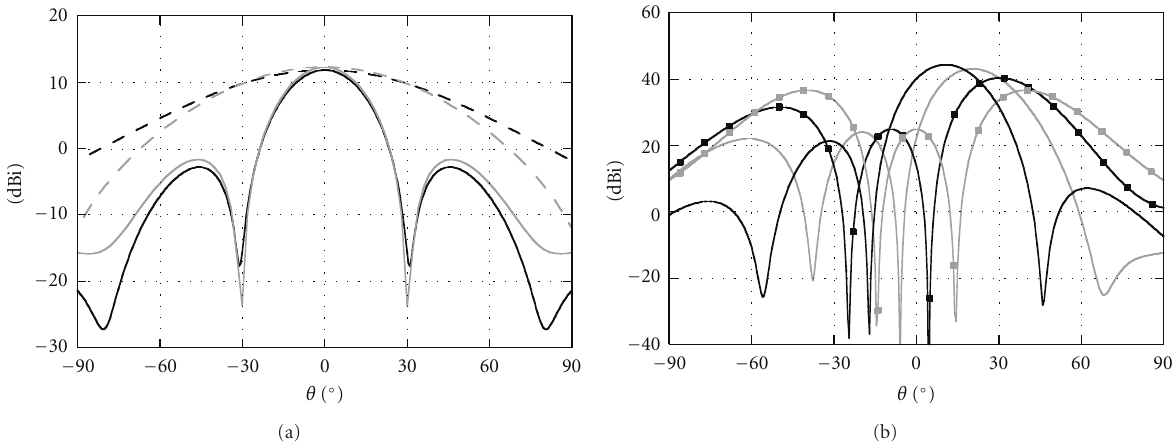
Figure 9: Array of 3 adjacent shielded cells as in Figure 2 at 5GHz. (a) Gain on the principal elevation planes φ = 0 ◦ ( solid lines ) and φ = 90 ◦ ( dashed lines ). Beam pointing at broadside ( θ = 0 ◦ , all the cells are excited in phase) by the upper patches ( black lines ) and by the lower patches ( gray lines ). (b) The three lower sets of patches are phased in order to point at θ = 10 ◦ ( black line ), θ = 20 ◦ ( gray line ), θ = 30 ◦ ( black line with squares ), and θ = 40 ◦ ( gray line with squares ).